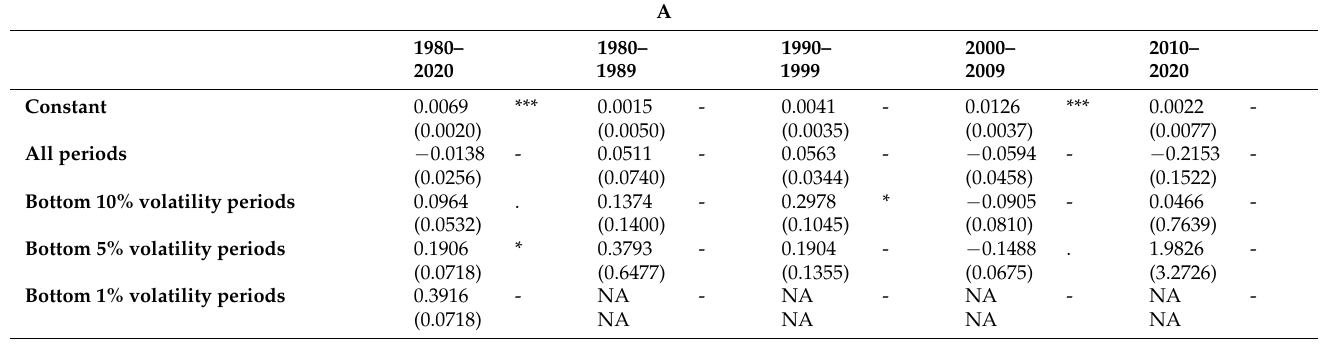
Table 6. Regression of gold returns on Sensex returns for periods of low volatility using GARCH.